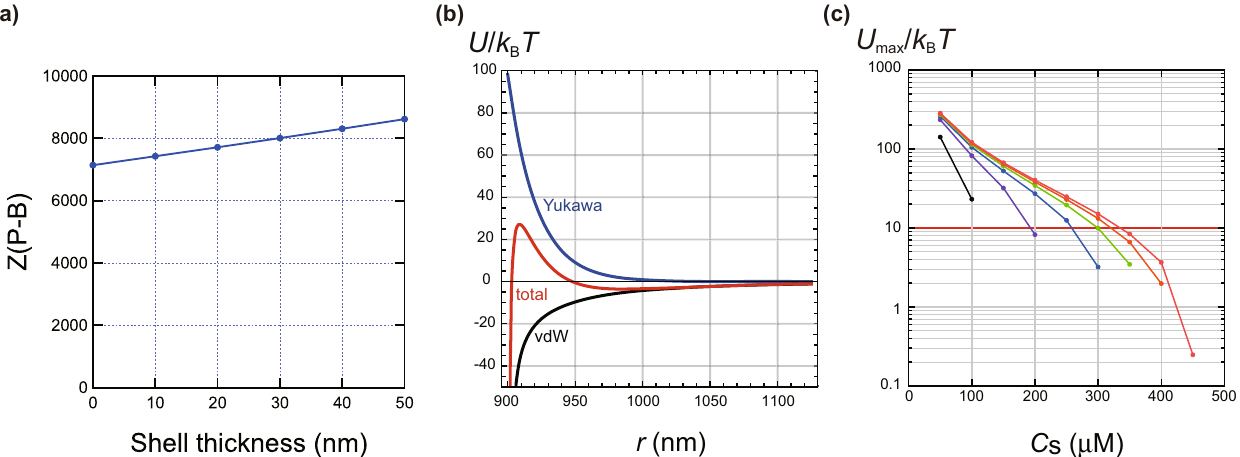
Fig. 9 Estimation of the effect of silica coat thickness on the number of charges and particle-particle interactions in titania particles. a Number of particle charges calculated assuming various SiO 2 shell layer thicknesses. b Interaction potential between TiO 2 -SiO 2 core-shell particles (Shell thickness 20 nm, C s = 200 µM). c Maximum values of the interaction potential between TiO 2 -SiO 2 core-shell particles (From top, shell thickness = 50, 40, 30, 20, 10, and 0